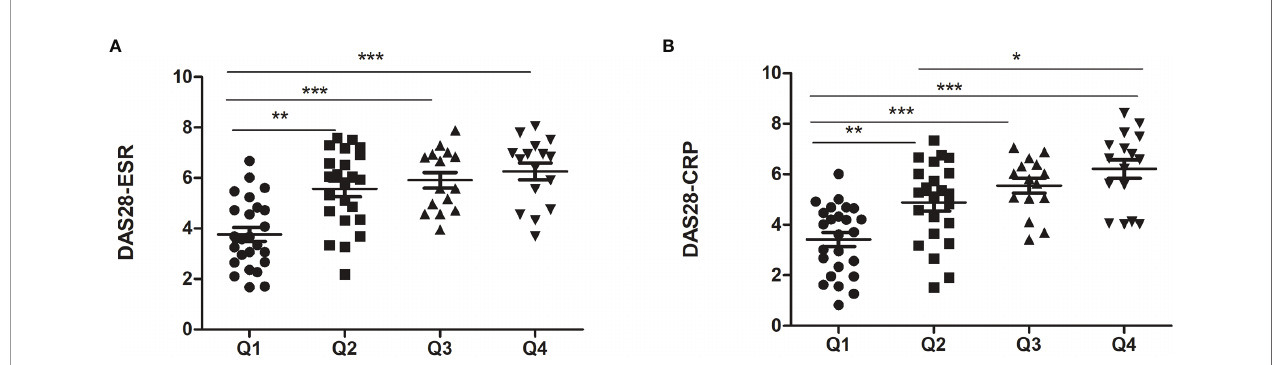
FIGURE 1 | Markers of disease activity in RA patients with different FSH levels. (A) for DAS28-ESR; (B) for DAS28-CRP. *p < 0.05, **p < 0.01, ***p < 0.001.